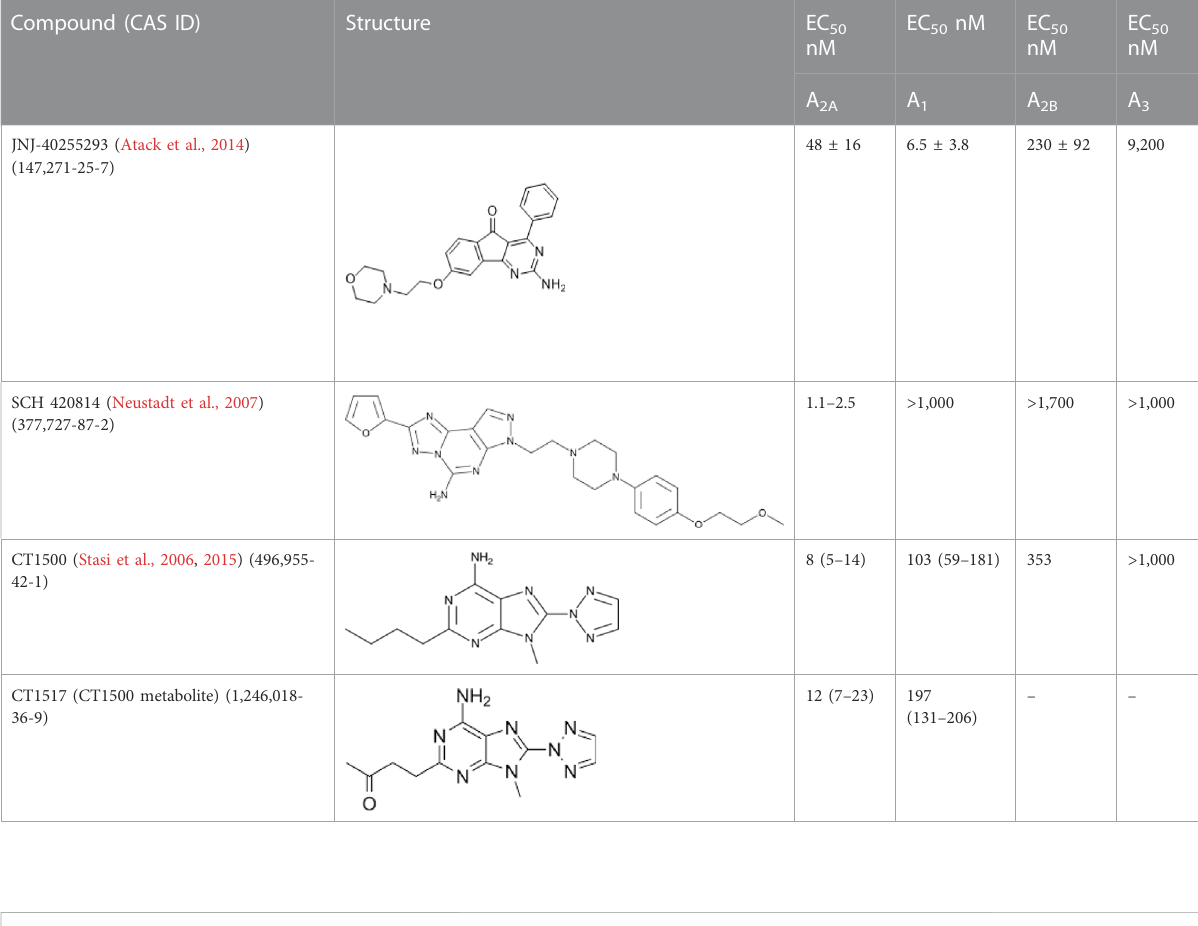
TABLE 1 The compounds used in this study, their structure and activity at the different adenosine receptors are detailed.